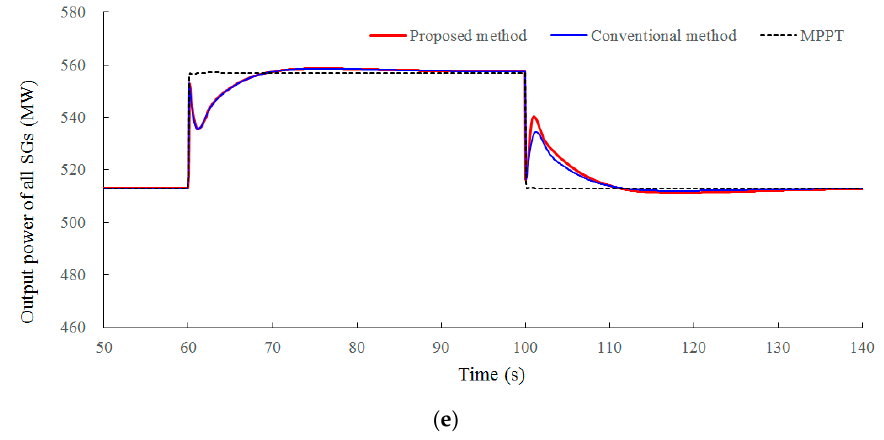
Figure 6. Simulations for Case 1: ( a ) System frequencies; ( b ) Active powers; ( c ) Rotor speeds; ( d ) Control gain; ( e ) Output power of all synchronous generators.